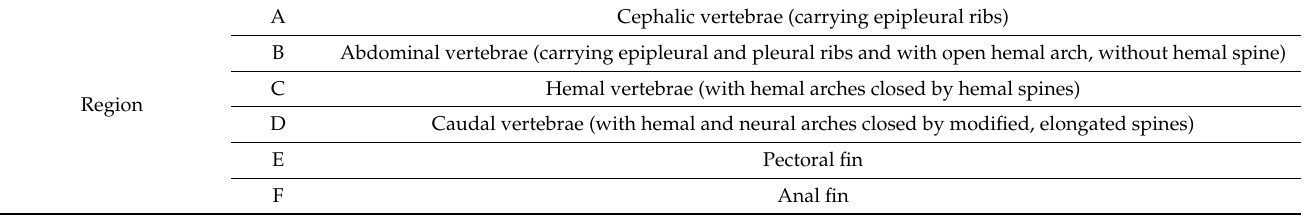
Table 2. List of the considered skeletal anomalies types. The letter indicates the body region; the number indicates the anomaly type, and the symbols *, # indicate a variation (or a sub-type) of the anomaly type. Severe anomalies are shown in